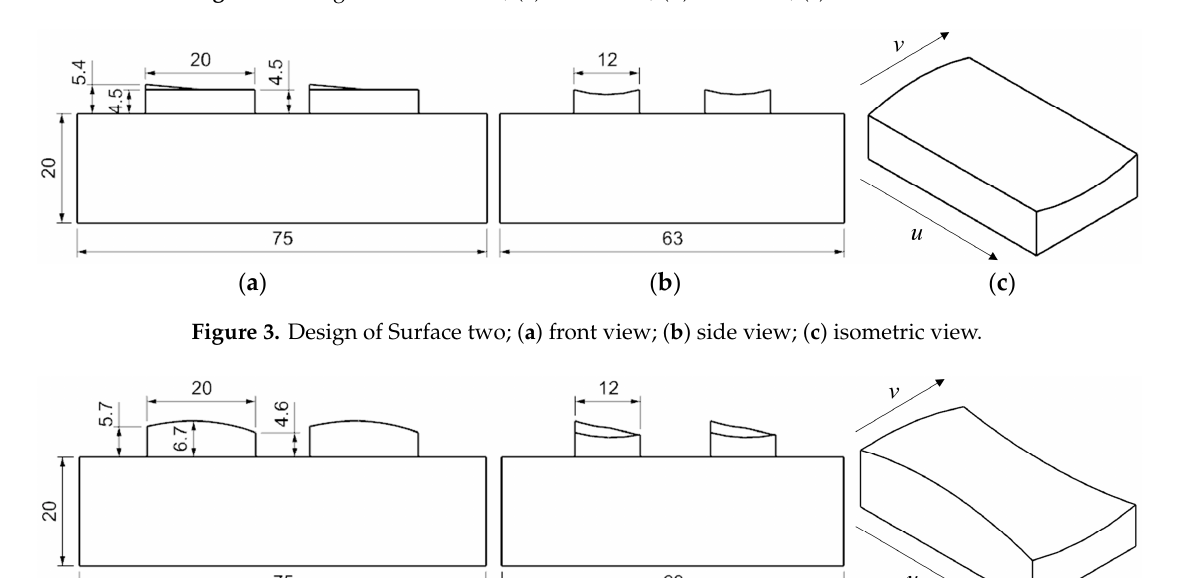
Figure 2. Design of Surface one; ( a ) front view; ( b ) side view; ( c ) isometric view.